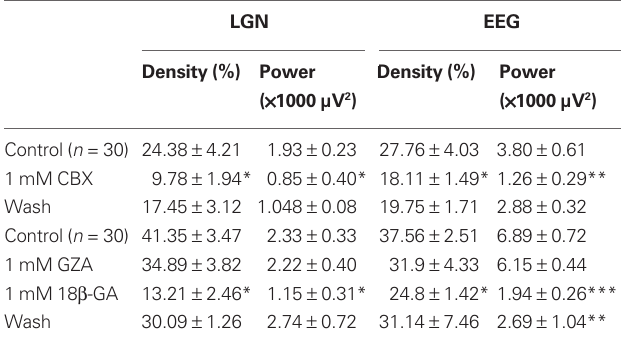
Table 1 | Effect of thalamic CBX, 18 β -GA, and GZA application on α rhythm density and power in vivo .